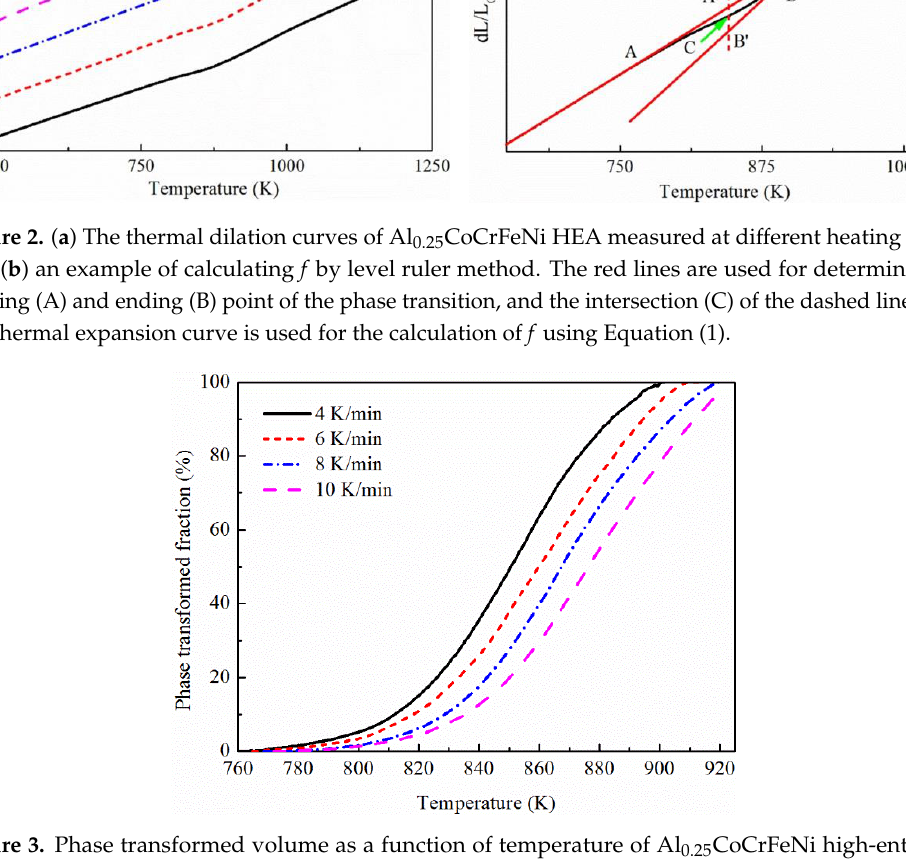
Figure 2. ( a ) The thermal dilation curves of Al 0.25 CoCrFeNi HEA measured at different heating rates and ( b ) an example of calculating f by level ruler method. The red lines are used for determine the starting (A) and ending (B) point of the phase transition, and the intersection (C) of the dashed line and the thermal expansion curve is used for the calculation of f using Eq.(1).